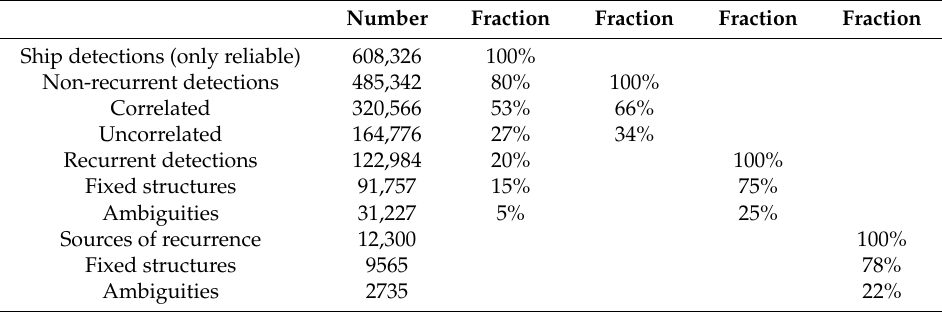
Table 3. Summary of the recurrence analysis (excluding off Israel